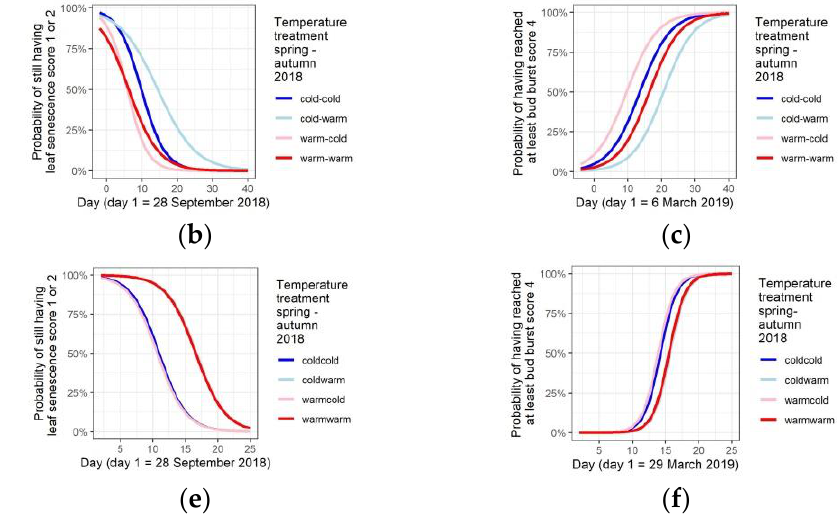
Figure 4. Modeled probability of having reached at least a given bud burst ( a , c , d , f ) or maximally a given leaf senescence ( b , e ), according to the temperature treatments in 2018. The modeled phenophases are shown for plants with an average height and belonging to the Belgian Corylus avellana for the Corylus taxa ( a – c ) and to the Belgian provenance for Cornus sanguinea ( d – f ). Bud burst is depicted for 2018 and 2019, while senescence is depicted for 2018. Table 4. Estimates and p -values for the modeled bud burst and leaf senescence for the years 2018 until 2020 for the Corylus taxa and for Cornus sanguinea . For the Corylus taxa, the standard taxon/re- gion is the Belgian Corylus avellana to which the Belgian intermediate forms (Be_Cx), the Belgian Corylus maxima (Be_Cmax), and the Spanish Corylus avellana (Sp_Cave) are compared. For Cornus sanguinea , the Belgian provenance is the standard provenance to which the Spanish provenance (Sp) is compared. The “cold–cold” condition in the te mperature treatments during 2018 is the standard to which the other three conditions “cold–warm”, “warm–cold” , and “warm–warm” are compared (Tcw, Twc, and Tww, respectively). For the bud burst in 2018, there were only two conditions, with the “cold” condit ion as the standard to which the “warm” condition is compared (Tw). H17 to H19